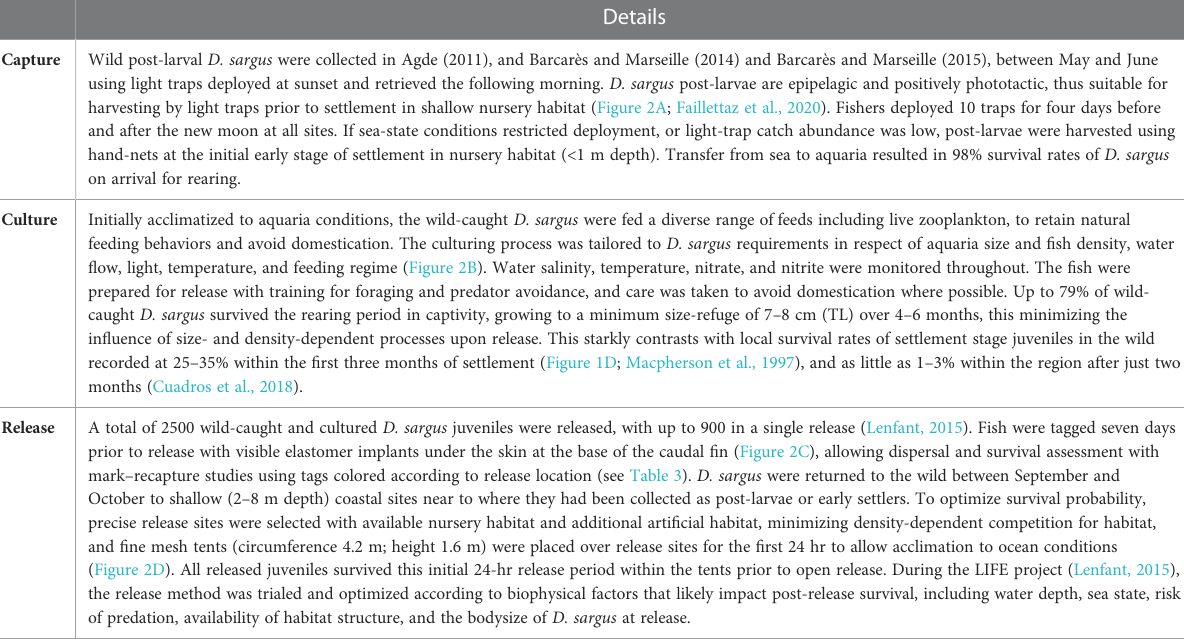
TABLE 2 ‘ The PCCR process ’ – Case study: Diplodus sargus in the French Mediterranean.